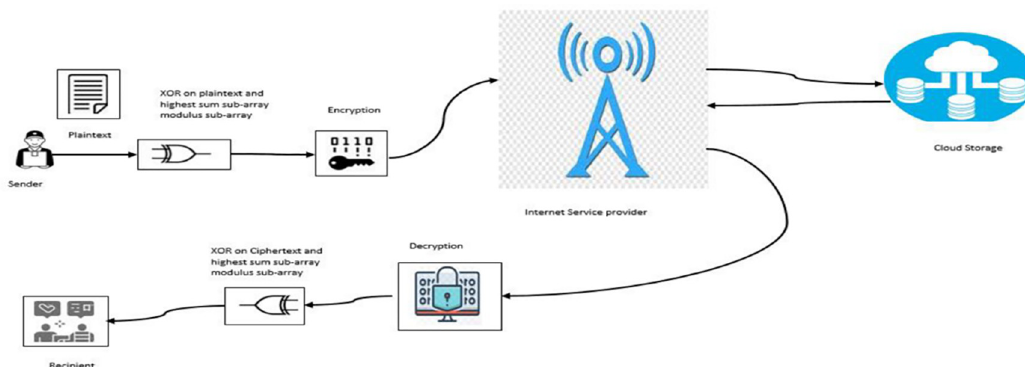
Fig 7. Architecture for the proposed